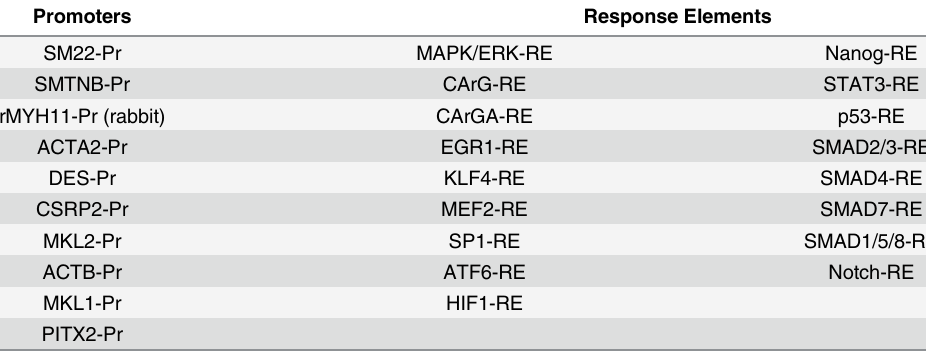
Table 1. List of Promoters and Response Elements cloned into LVDP. Promoters Response